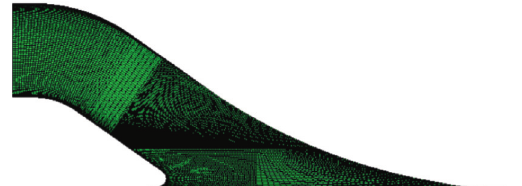
Figure 3: Inlet duct structured grid.